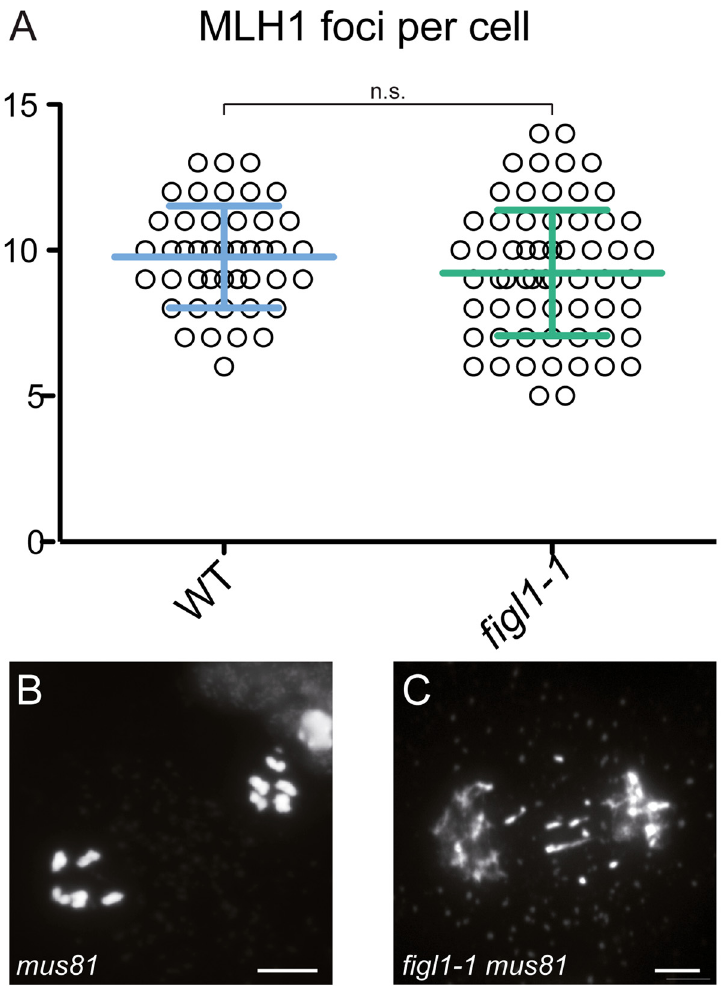
Fig 4. FIGL1 limits MUS81 -dependent CO formation. A: MLH1 foci number is unchanged in figl1-1 compared to wild type. B-C: Anaphase I in mus81 (B) and figl1-1 mus81 double mutant (C), the latter displays chromosome fragments indicative of unrepaired recombination intermediates. Scale bar = 5 μ